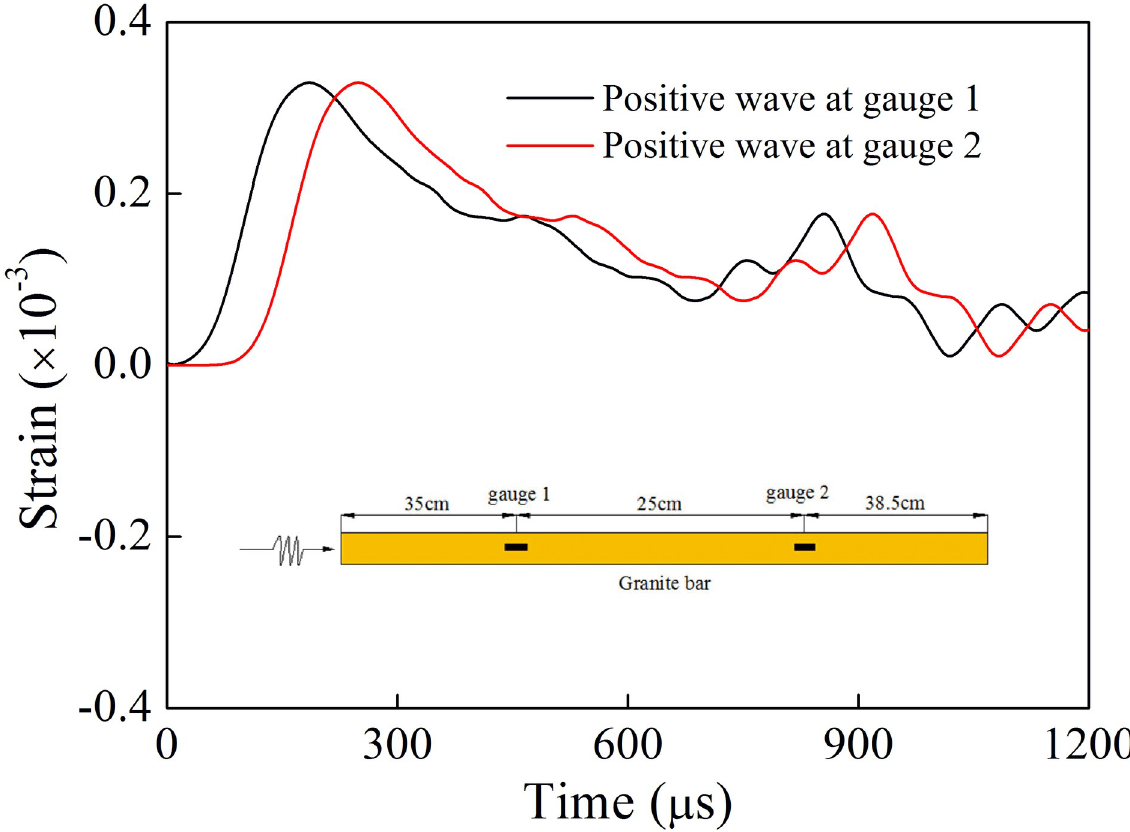
Fig 10. The strain time history at gauge 1 and 2 (52.0 GPa/s).